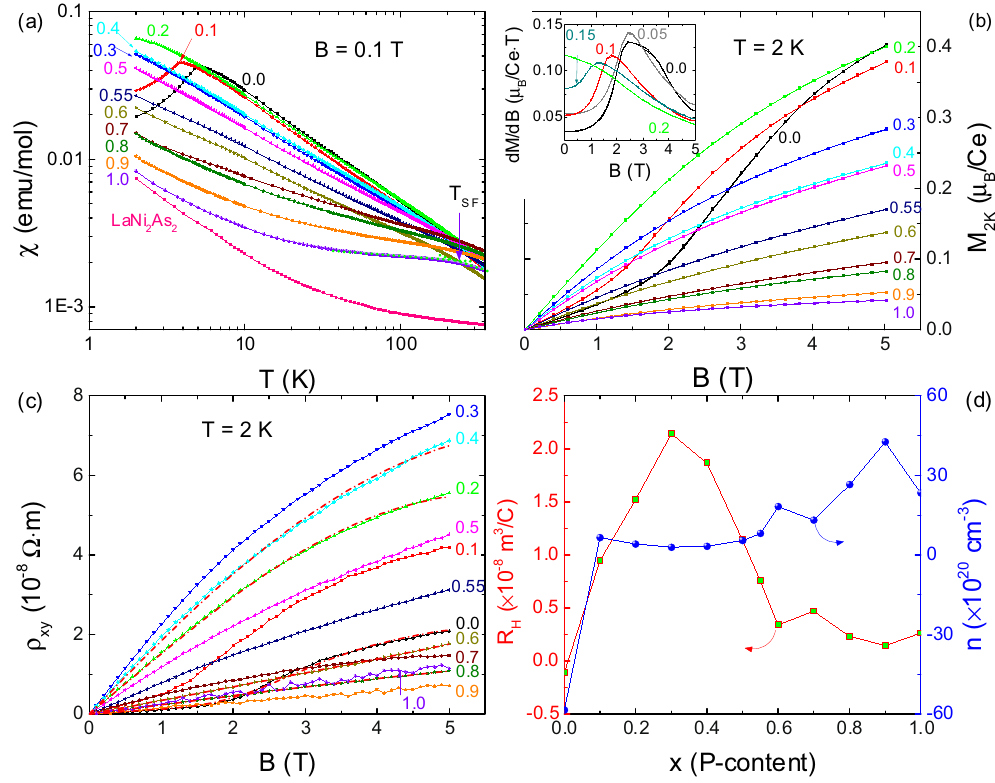
Figure 2. T ( ) χ ( a ) and M 2 K ( B ) ( b ) of CeNi 2 − δ (As 1 − x P x ) 2 for the selected concentrations. ( c ) Magnetic field ρ , measured at T = 2 K. The red dashed lines present the fitted curves for dependence of the Hall resistivity, B ( ) xy selected samples ( x = 0.0, 0.2, 0.4, 0.6 and 0.8) using Eq. 1 (see the text). ( d ) The x evolution of the Hall coefficient R H and the carrier density n on the left and right panel, respectively. Inset to ( b ) presents d M /d B versus B at T = 2 K for x =